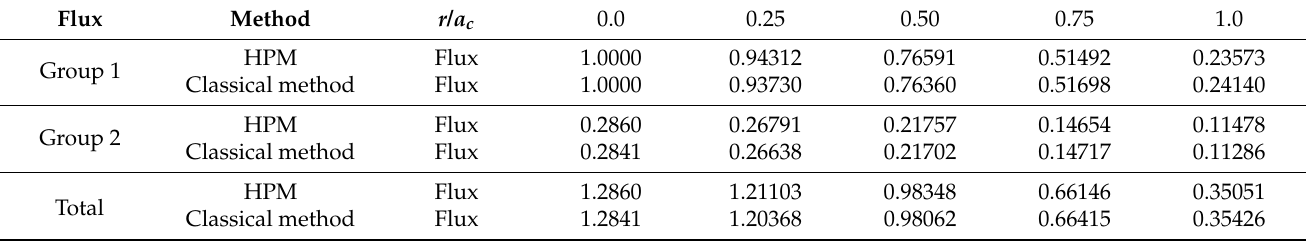
Table 14. Two-group reflected reactor fluxes and total flux.